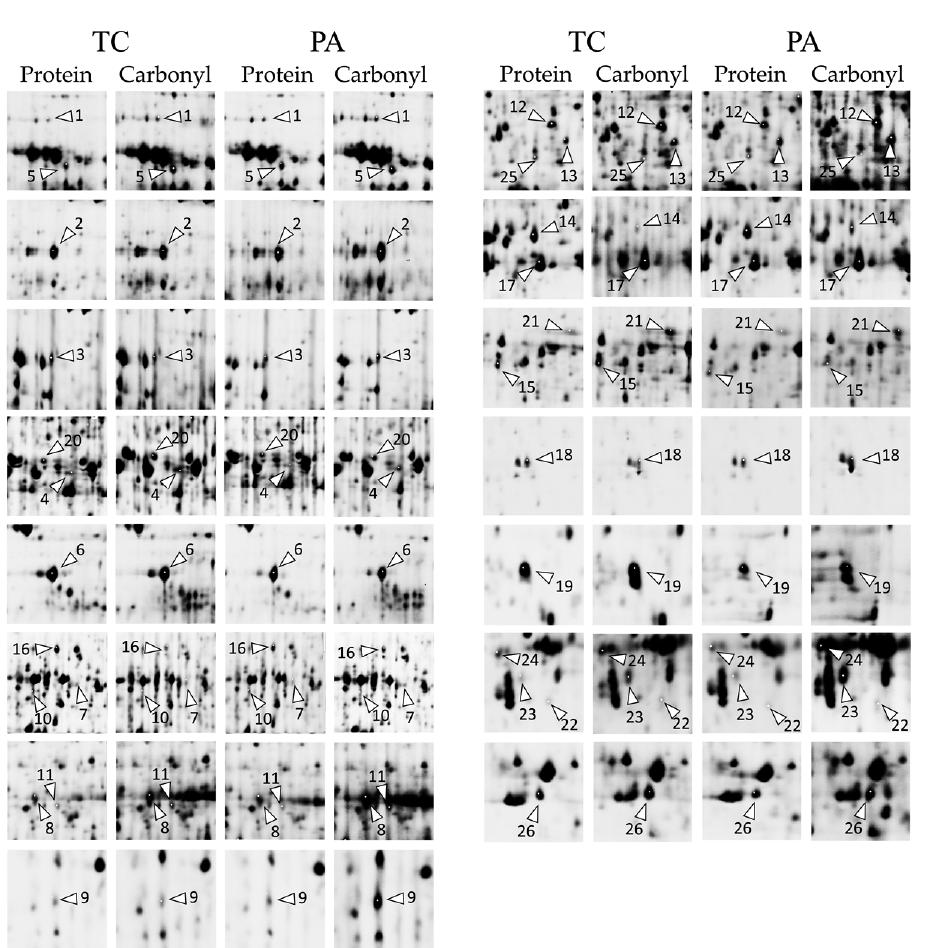
Figure A3. Comparison of differentially carbonylated proteoforms between control (TC) and timentin-treated (PA) tobacco in vitro shoot samples were collected after one week of cultivation (day 7). Column labels indicate representative images of data collected based on the amine-reactive Cy3 dye labeling intensity (protein) and protein carbonyl modification abundance detected based on the content of carbonyl-reactive CF647DI dye derivatization (carbonyl). Arrows indicate protein spots identified by mass spectrometry and the spot numbers correspond to proteoform numbers in Table 2. Data shown are representative of four biological replicates.